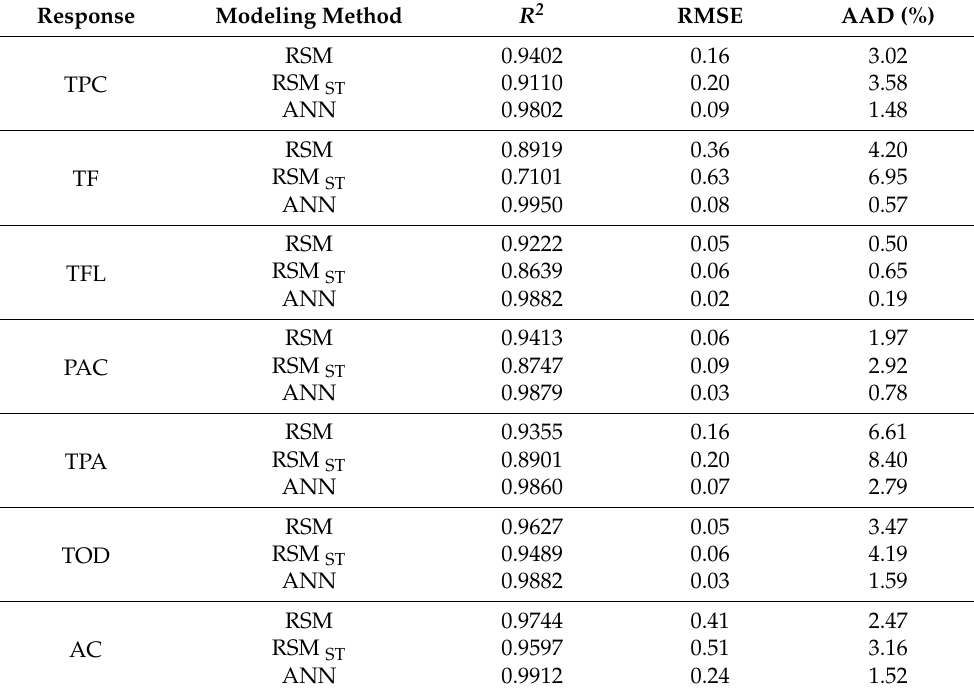
Table 2. Comparison of optimization and prediction capabilities of response surface methodology (RSM) and ANN for the extraction of total phenolic compounds (TPC), total flavonoids (TF), total flavanols (TFL), total proanthocyanidins (PAC), total phenolic acids (TPA), total o -diphenols (TOD), and the in vitro antioxidant capacity (AC). R 2 : the coefficient of determination; AAD: absolute average deviation. Response Modeling Method R